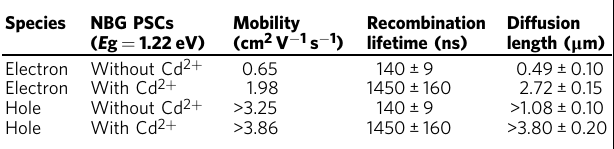
Table 1 Carrier mobility, recombination lifetime and diffusion length in 1000-nm-thick NBG PSCs with and without 0.03% Cd 2 + ions Species NBG PSCs ( E g = 1.22